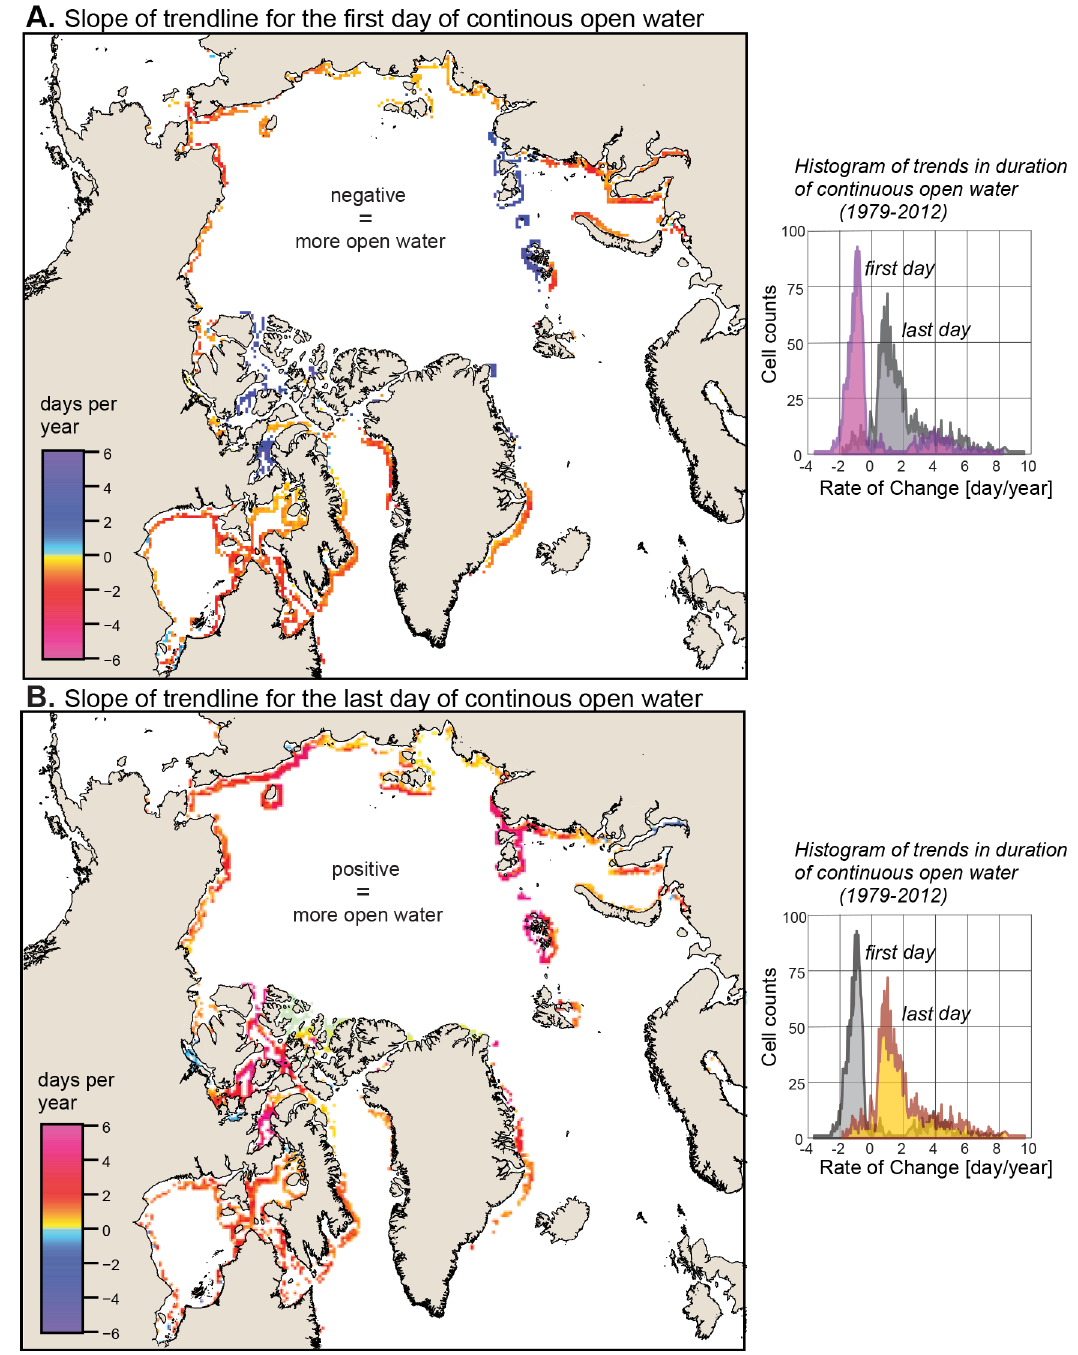
Figure 2. Trends in the first (a) and last (b) day of continuous open water across the Arctic. Inset histograms show the distribution of trend line values. Only cells with p values of less than 0.05 are shown. The rate of expansion into the fall is greater than in the spring. There are more days with significant trends in the last day of open water than the first. Note that the color axis has been flipped so that blue represents expanding open water in both